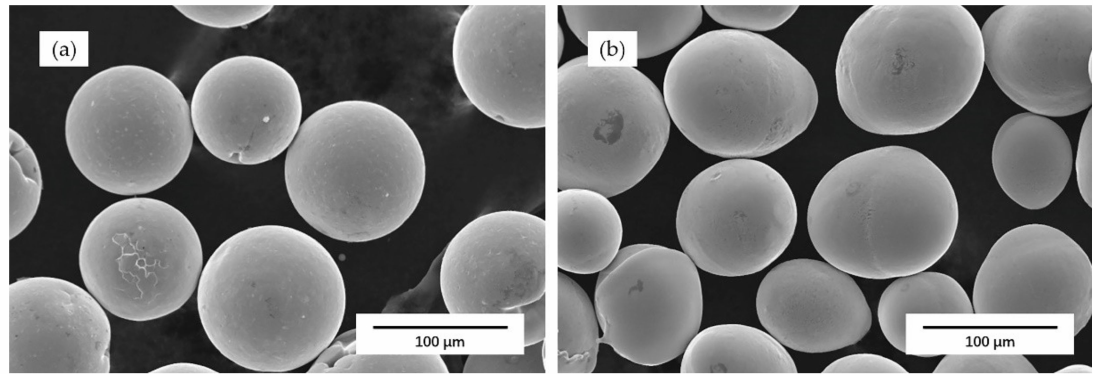
Figure 1. SEM microstructure of powders used in experiment: ( a ) Single Ni powder; ( b ) 55 NiTi alloy